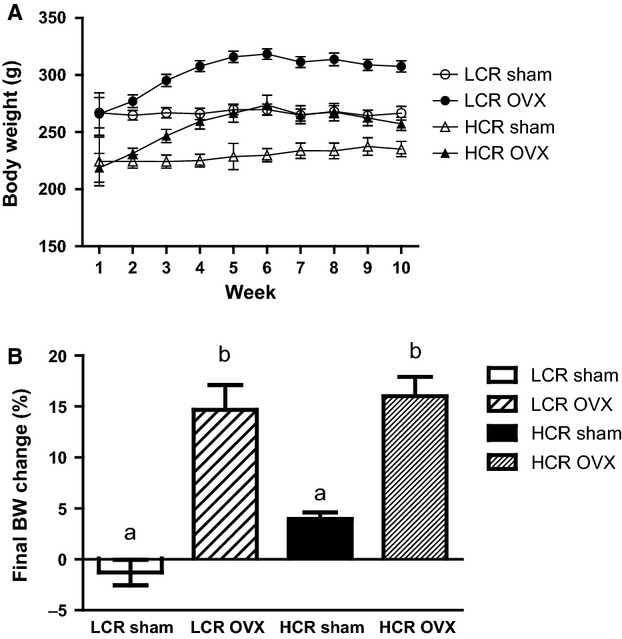
HCR rats weigh significantly less than LCR across treatments, but gain equivalent percent body mass with OVX. Weekly body weight gain (A) and percent total body weight gain (B) over 9 weeks in LCR and HCR Sham or OVX rats (n = 8–10/group). ANOVA followed by Tukey post hoc analysis. Unlike letters are significantly different: P < 0.01.